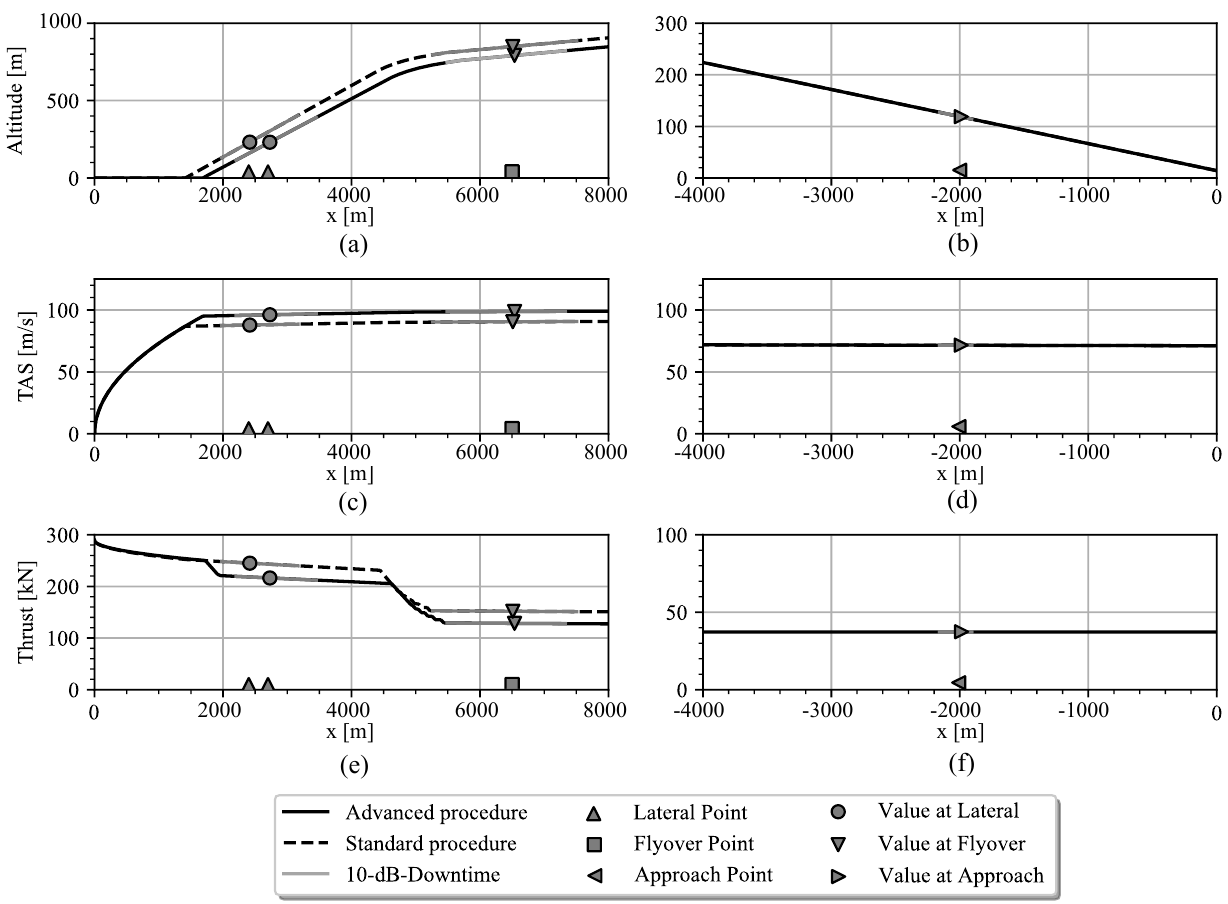
Figure 6. Take-off ( left ) and approach ( right ) flightpaths (altitude ( a , b ), calibrated airspeed ( c , d ) and total thrust ( e , f )) as result of optimization for standard and advanced procedure. Flyover, lateral and approach measurement points as well as operation condition above measurement points and relevant part of flightparameters for EPNL calculation (10-dB-Downtime) are marked. The x position is specified relative to the brake-release point for take-off and relative to the runway threshold for